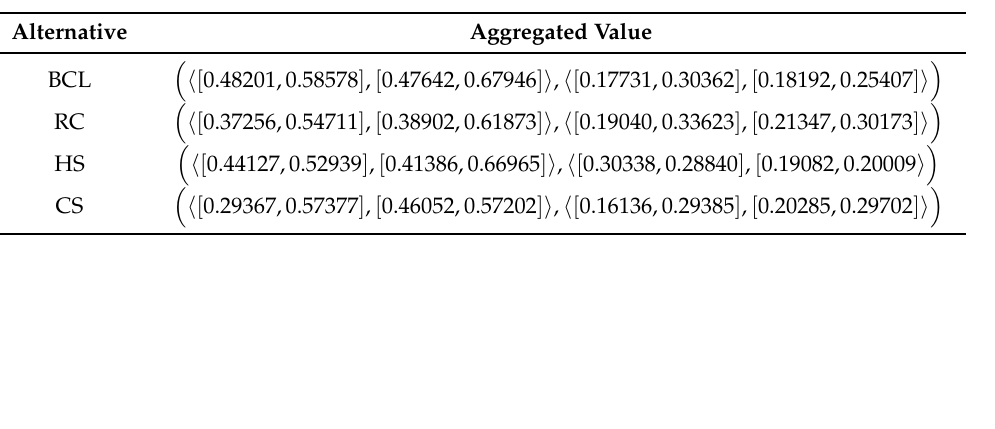
Table 4. Aggregated IVLDF